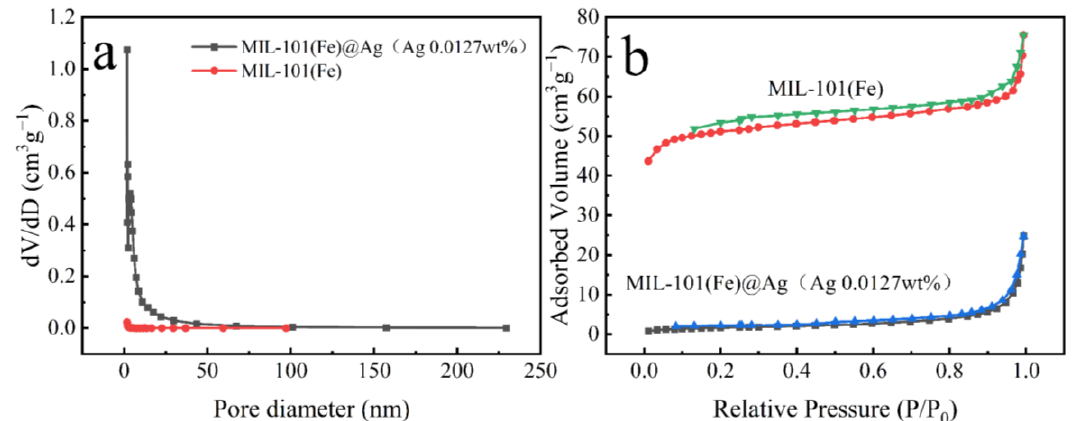
Figure 9. ( a ) Pore-size distributions of MIL-101(Fe)@Ag (Ag 0.0127 wt%) and MIL-101(Fe). ( b ) Ad- sorption and desorption curves of MIL-101(Fe)@Ag (Ag 0.0127 wt%) and MIL-101(Fe).